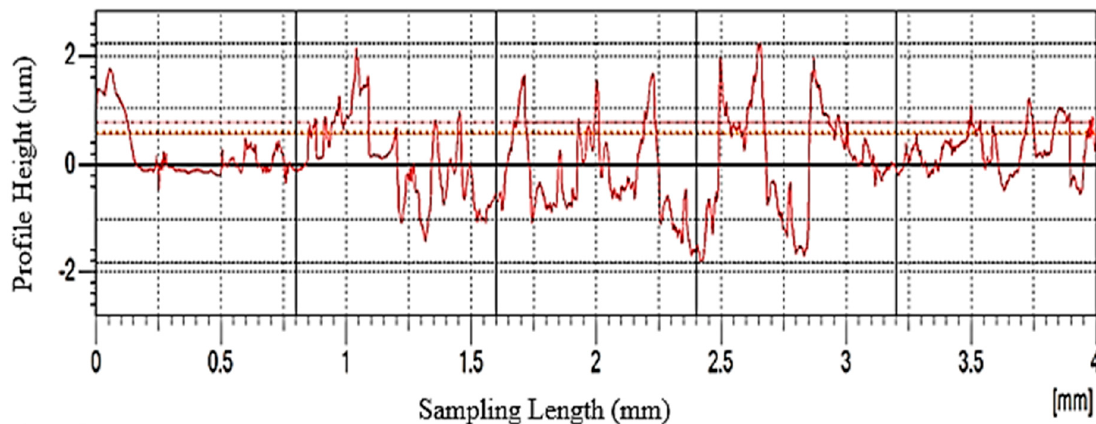
Figure 4. Surface roughness measurement graph.